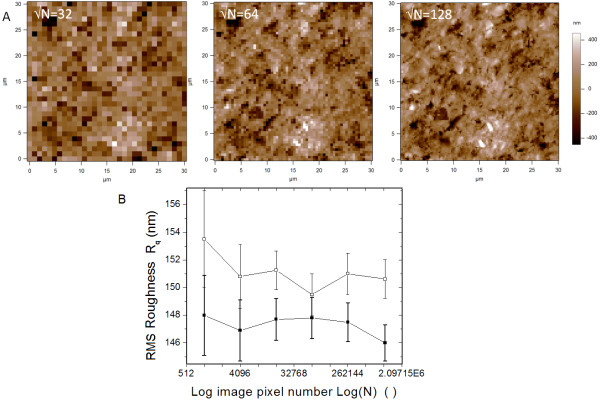
Effect of pixel number of AFM images on the measured roughness. A) AFM height images of a control specimen (untreated composite surface) for which the same region has been imaged (scan size S = 30 μm) with increasing number of pixels, N = 322, 642, and 1282 from left to right. Height range is 900 nm for all images. Images not shown here completed the sequence, with N = 2562, 5122, and 10242. B) Values or RMS roughness Rq are reported for the whole set of AFM images with different N. Error bars represent semidispersion of forward and backward scans. Empty squares are from raw AFM data, filled squares are Rq values after zero order image flattening. Lines are just guides to the eye.